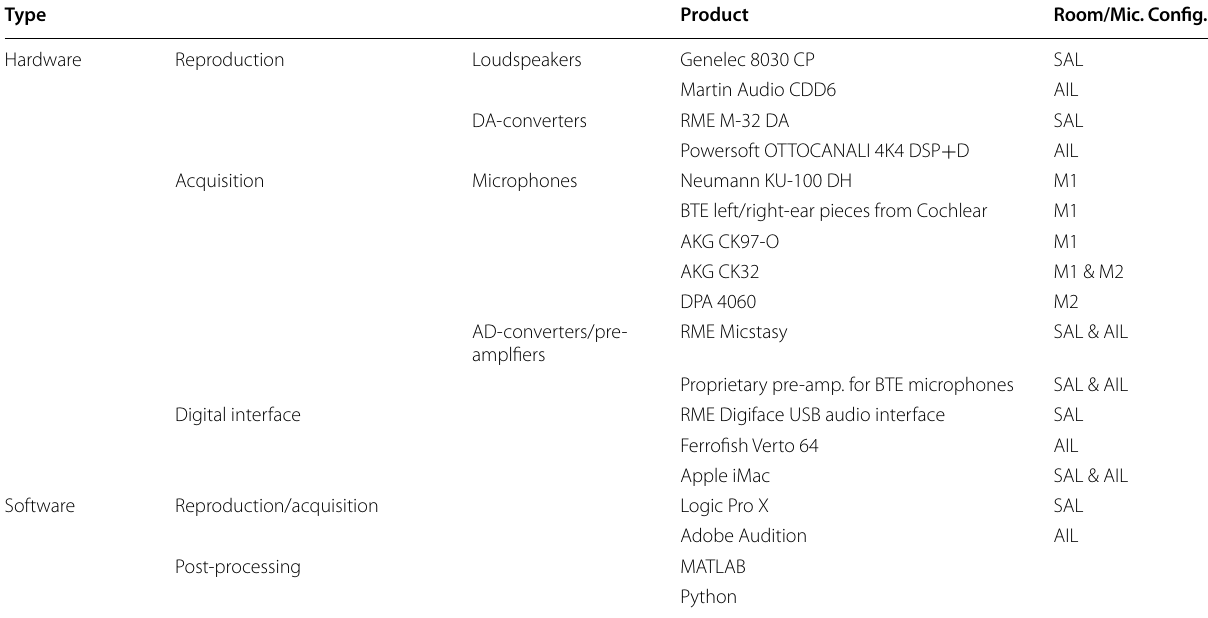
Table 1 Equipment used for creating the database Type Product Room/Mic. Config.